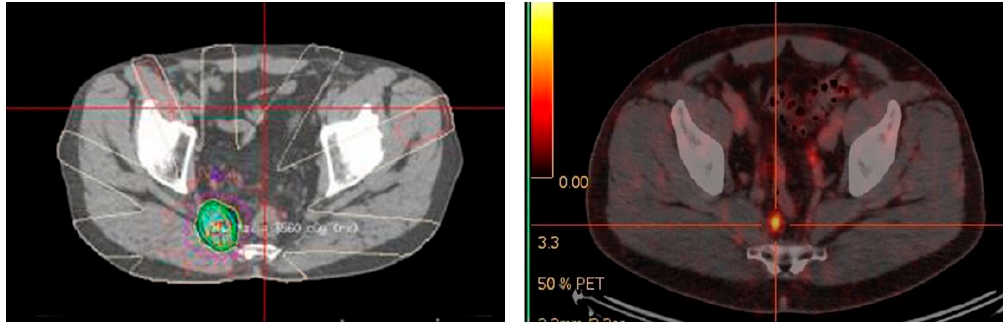
Figure 4. Targeted radiotherapy to recurrent 68 Ga-PSMA avid right pre-sacral lymph node. June 2015.